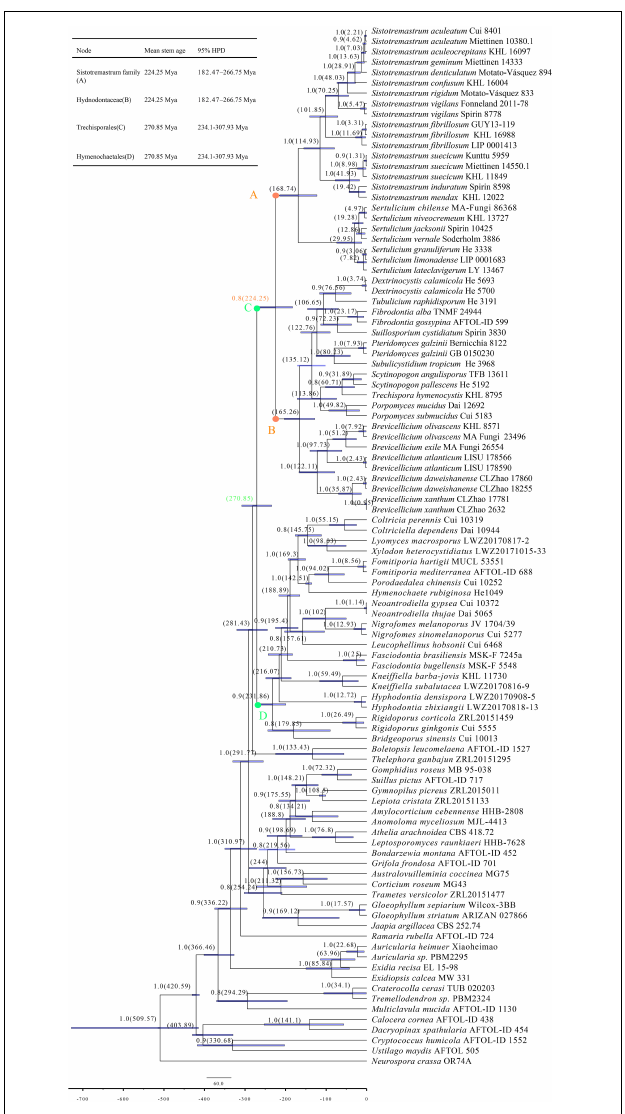
FIGURE 3 | Maximum clade credibility (MCC) chronogram and estimated divergence times of all main lineages in Basidiomycota inferred from the combined data set of 5.8S and LSU regions. The estimated divergence times of 95% highest posterior density (HPD) for all clades are indicated as node bars. The colored dots refer to the positions of the mean stem age of Sistotremastrum family, Hydnodontaceae, Trechisporales, and Hymenochaetales. The BPP above 0.8 and the mean divergence times of clades are labelled above and below the branches, respectively, at the nodes.